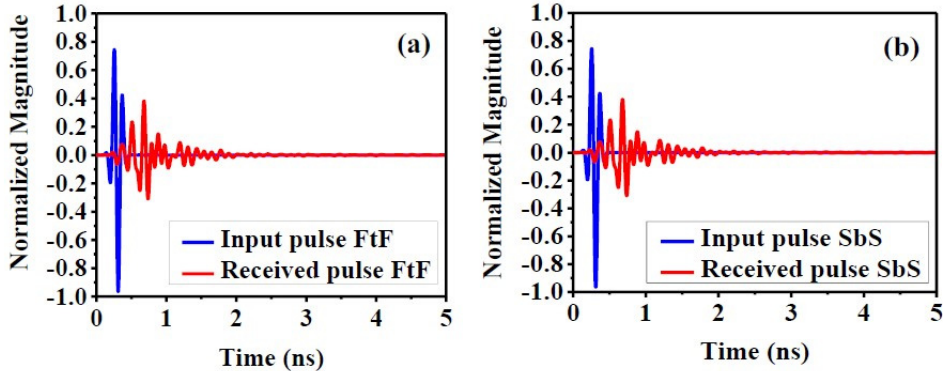
Figure 12. Normalized transmitted and received pulse in: ( a ) face-to-face, ( b ) side-by-side.